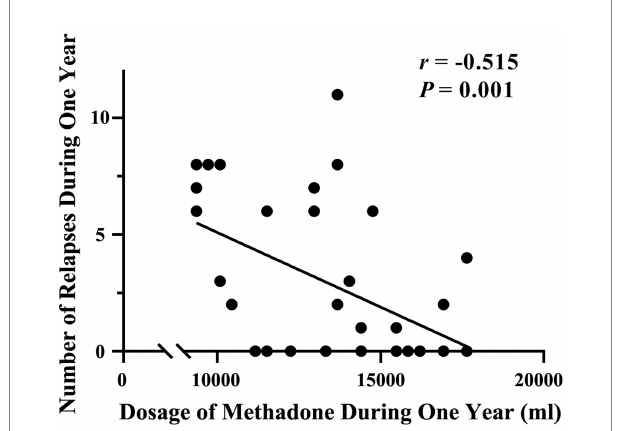
FIGURE 3 Correlation between the number of relapses and total methadone dose during the one-year follow-up